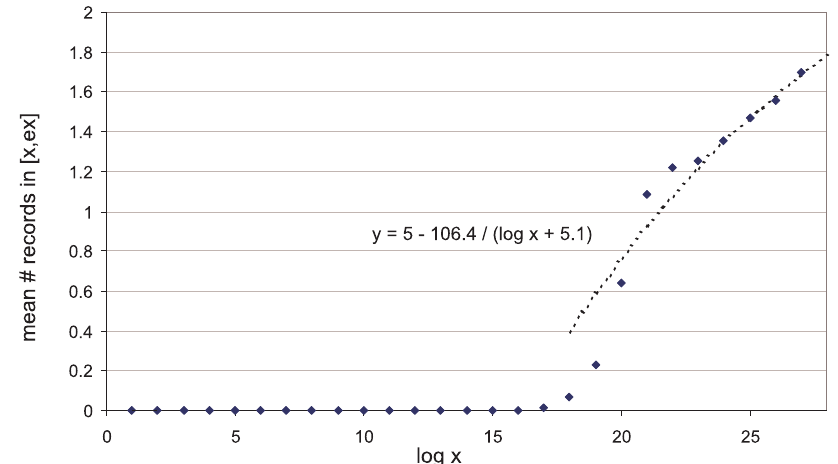
Figure 9. Prime quadruplets ( p , p + 2, p + 6, p + 8), p = r + nq ∈ P c , k = 4, q = 16001. Mean number of maximal gaps G c observed for p ∈ [ x , ex ] , x = e j , j ≤ 27. Averaging for all H -allowed r . Dotted curve is a hyperbola with horizontal asymptote y =